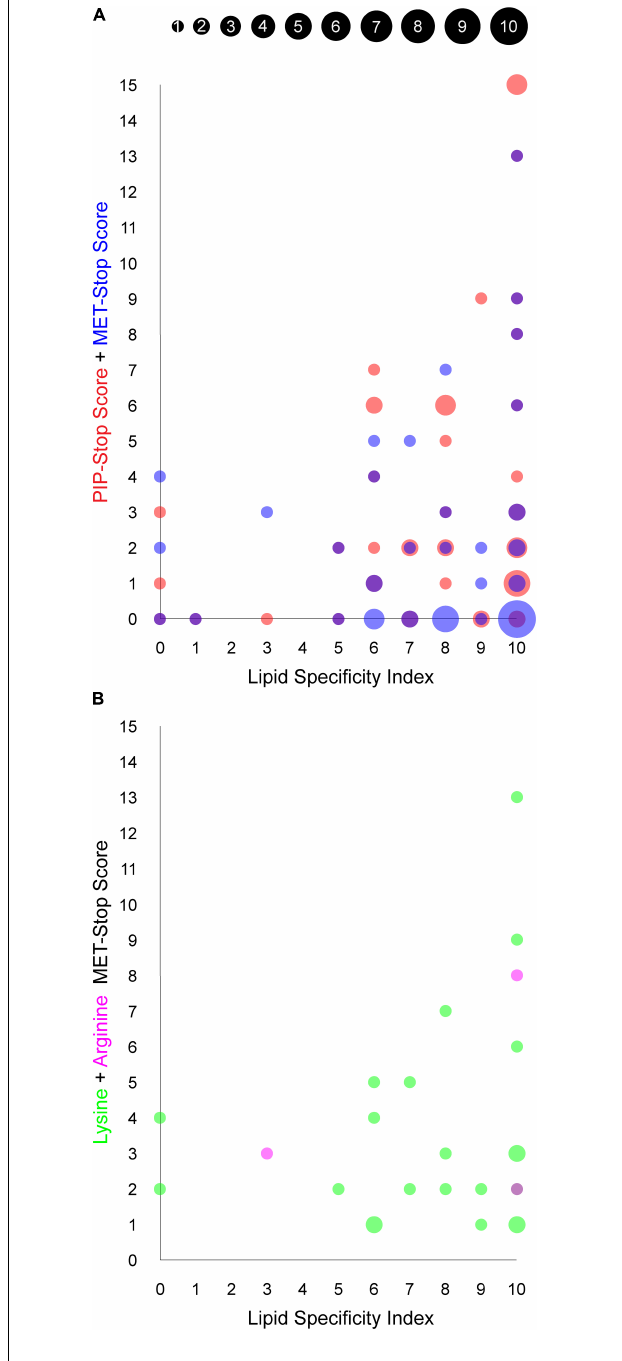
FIGURE 4 | Relationship between PIP binding specificity and post-translational modifications of PX domains. The area of each circle is proportional to the number of PX domains that occupy the position of the circle, as indicated in the inset and are based on values in Table 1 . (A) The PIP-stop score (PSS) and MET-stop score (MSS) of each human PX domain is plotted against its Lipid Specificity Index (LSI), shown in red and blue, respectively, while overlapping circles appear purple. (B) The contributions to the MSS from lysine and arginine modifications for each PX domain, discounting scores of zero, are shown in green and magenta, respectively, while overlapping circles appear